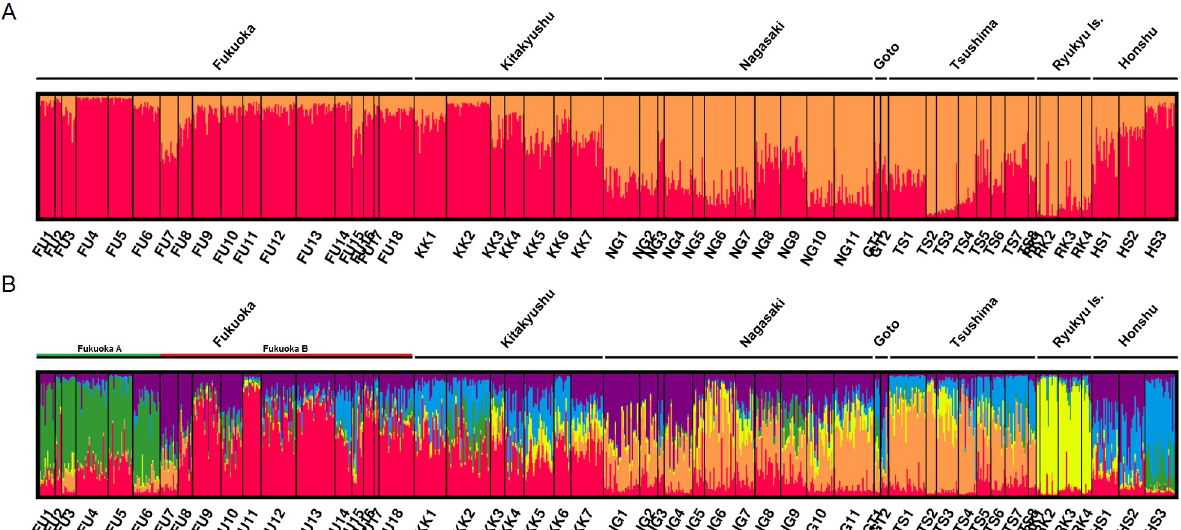
Fig 2. Bayesian membership assignment of Ae . albopictus individuals from Japan. Only results supported by Evanno’s best K are shown. (A) indicates the cluster assignment with K = 2, red: cluster 1; orange: cluster 2. (B) shows the cluster assignment with K = 6, red: cluster 1; orange: cluster 2; yellow: cluster 3; green: cluster 4; blue: cluster 5; and purple: cluster 6.